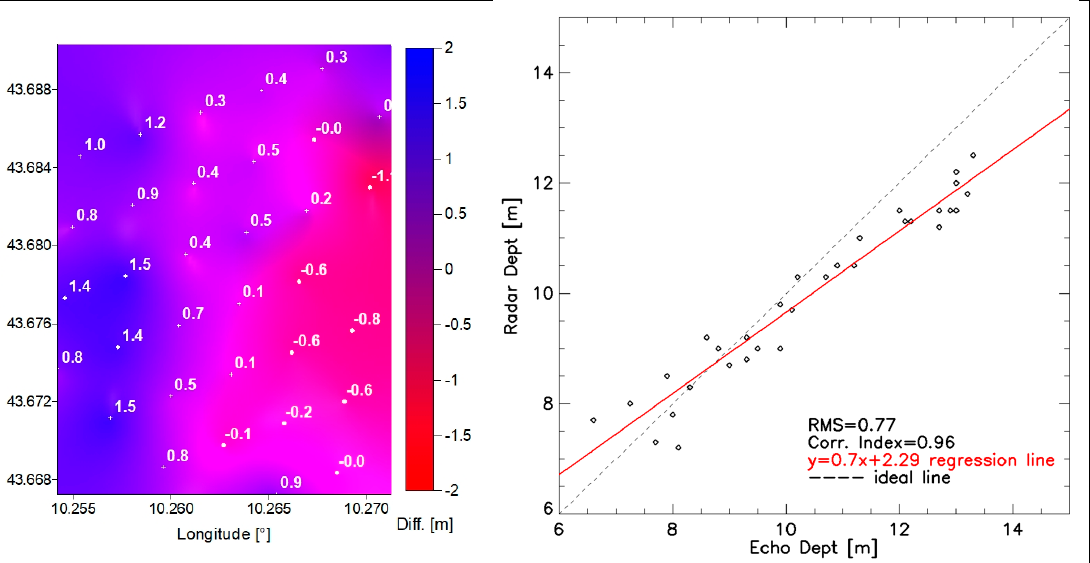
Figure 7. Map of the differences between the bathymetry measurements made with the echosounder and Wave Radar ( left ); scatterplot with regression line ( right ) and correlation index. Wave Radar images from 26 to 28 February and 3 March 2020 show the changes in the depth of the seabed (Figure